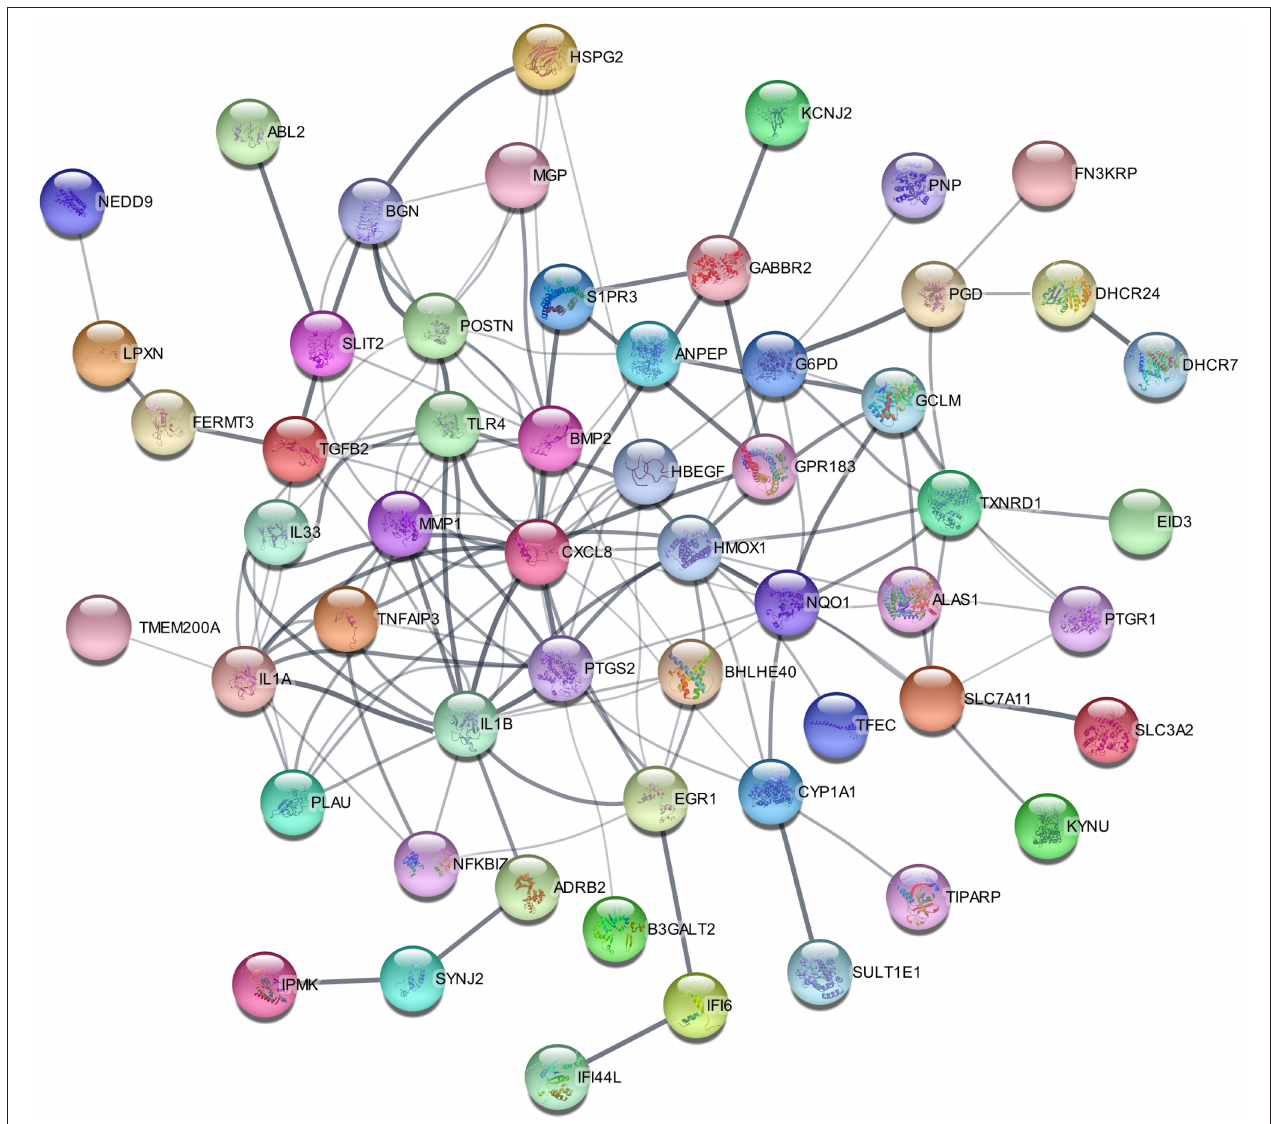
FIGURE 3 | PPI network of 65 DEGs with 140 interaction